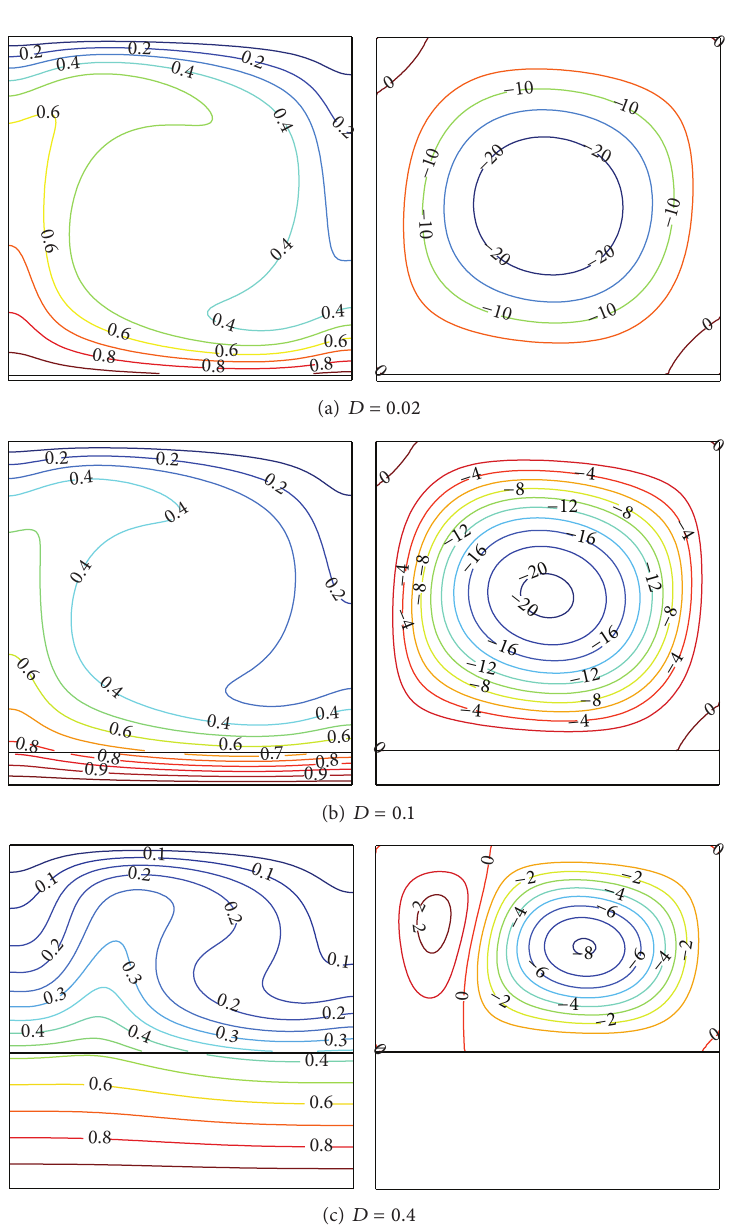
Figure 3: Isotherms (left) and streamlines (right) at Ra = 10 5 and Kr = 1